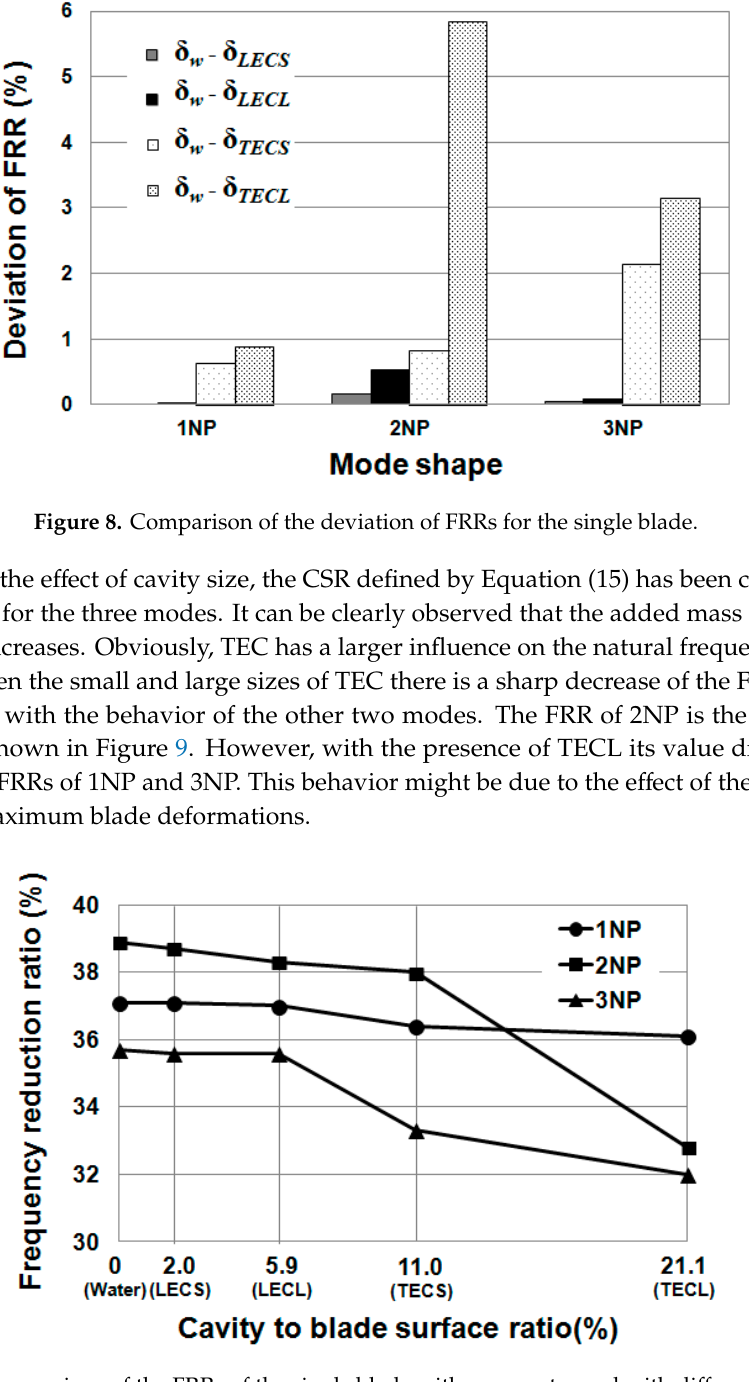
Figure 9. Comparison of the FRRs of the single blade with pure water and with different cavities.